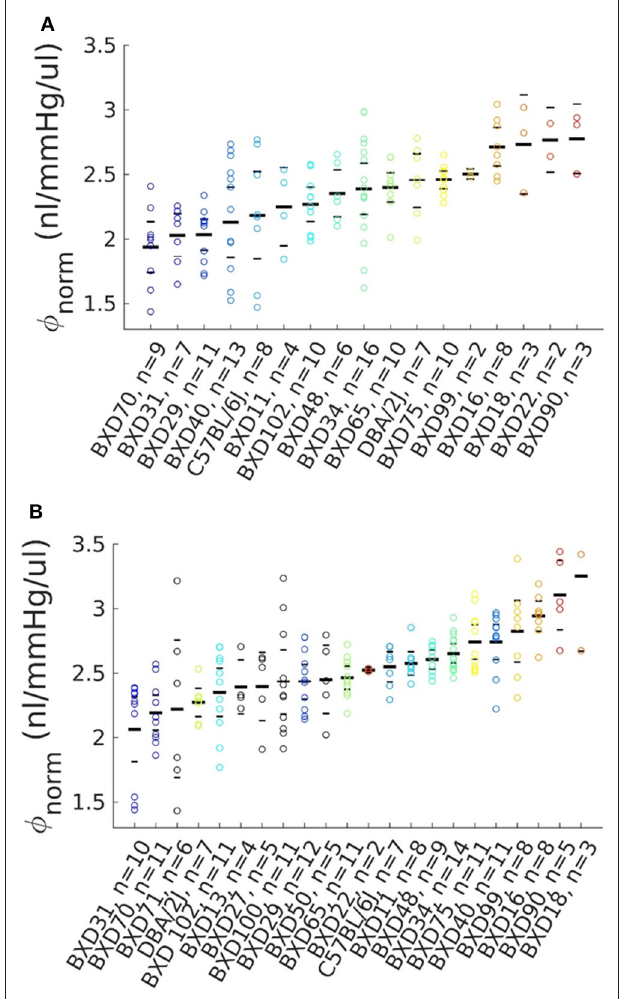
FIGURE 1 | Volume-normalized ocular compliance from BXD mice. Bars mark the mean and limits of the 95% confidence interval for each strain, with each point representing one eye. Number of eyes is shown for each strain. (A) Compliance calculated using the Volume Filling method (see text), n = 129 eyes across 17 BXD strains. (B) Compliance calculated using the Step Response method (see text), n = 179 eyes across 22 BXD strains. The color scheme from strains included in the Volume Filling data set (A) is preserved in (B) , with additional strains shown in